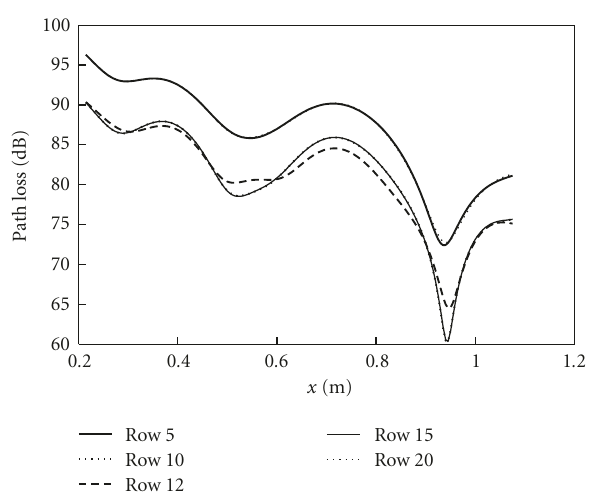
Figure 19: Propagation loss inside the cabin as a function of distance from the